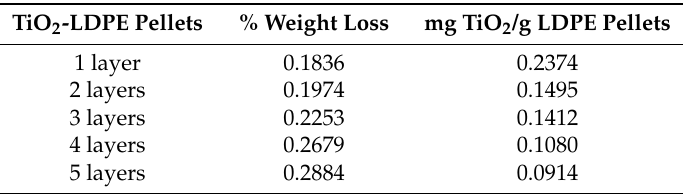
Table 2. Percentage of TiO 2 weight loss and amounts of TiO 2 incorporated on TiO 2 ‐ LPDE pellets with a different number of layers.